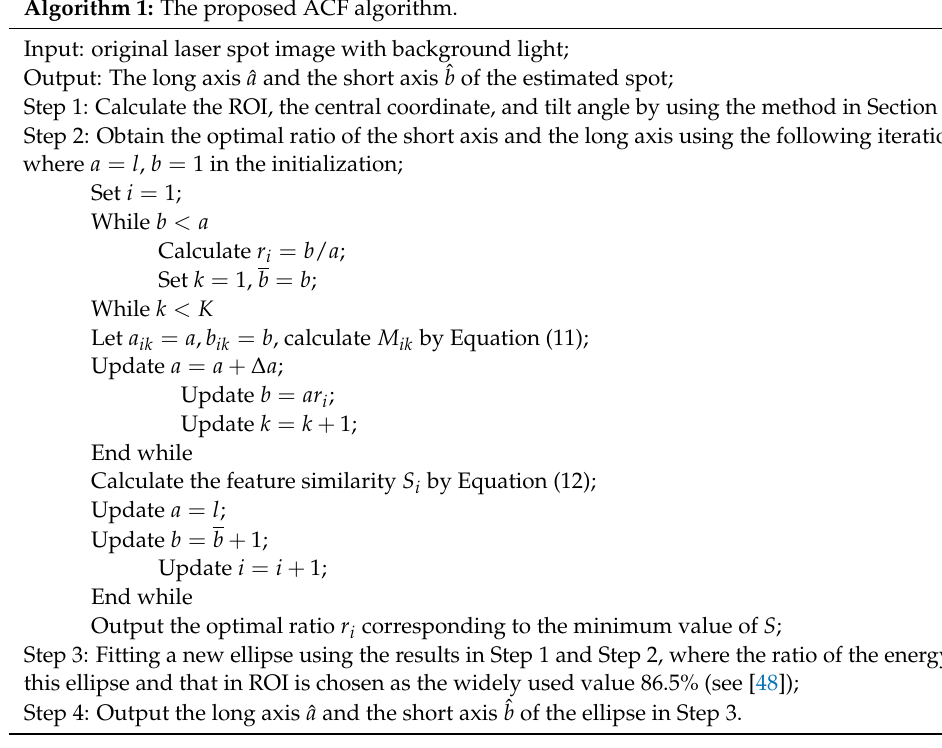
Algorithm 1: The proposed ACF